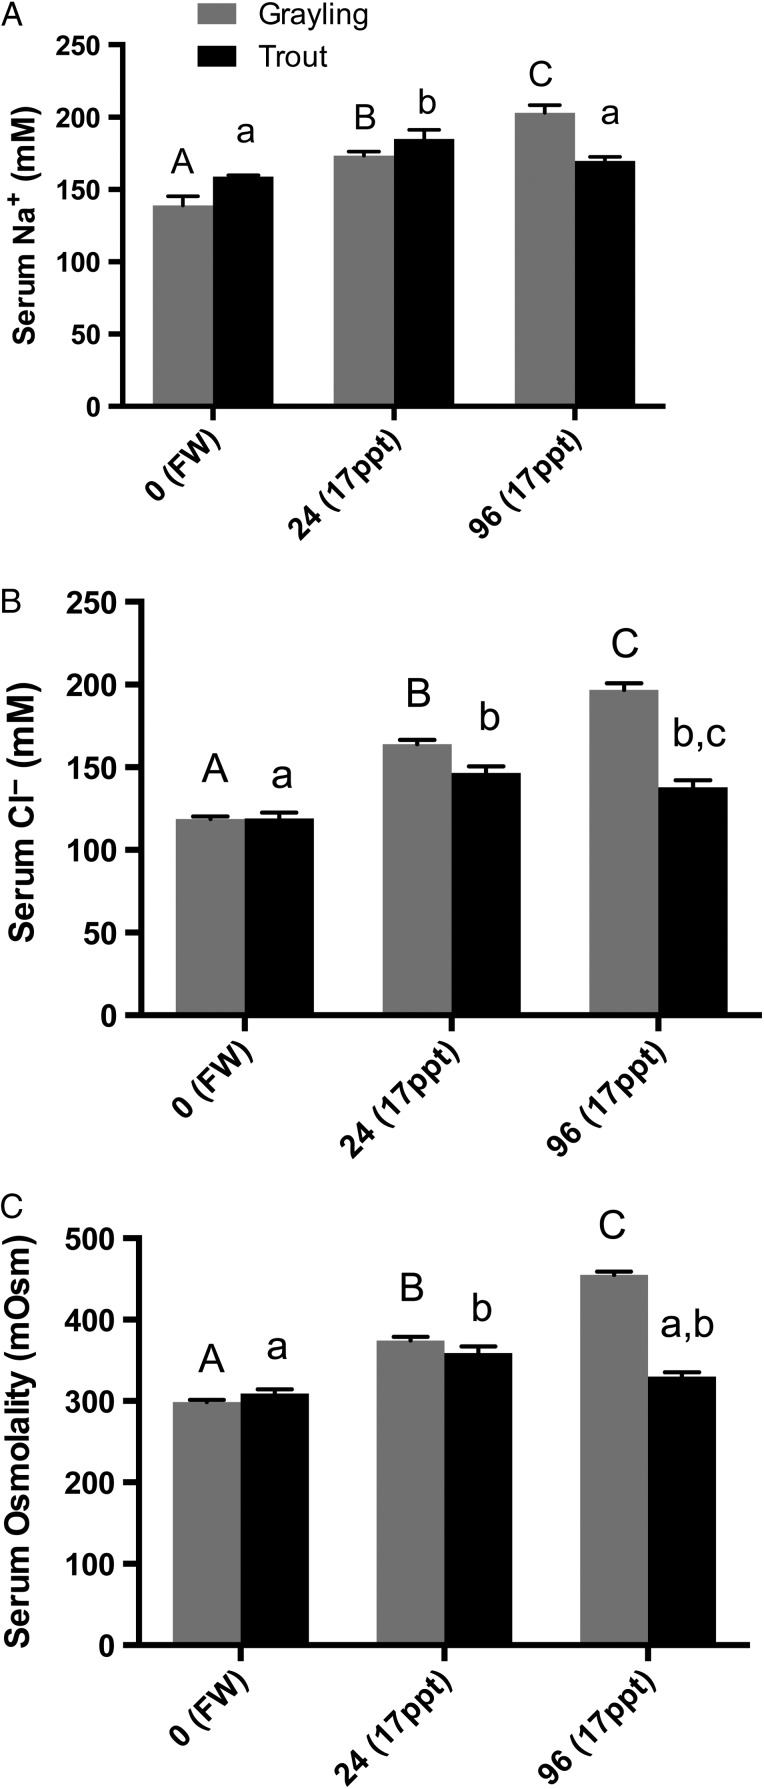
Serum sodium [Na+] (A), serum chloride [Cl−] (B) and serum osmolality (C) of Arctic grayling and rainbow trout exposed to freshwater (control; FW) and 17 ppt saline water at 24 and 96 h. Grayling and trout demonstrating significant increases in serum ions and osmolality at 24 h, and by 96 h serum concentrations were further elevated in grayling, but rainbow trout levels returned near to or were at control values. Grayling (grey bars) and rainbow trout (black bars) values are means + SEM, while dissimilar letters demonstrate significance using one-way ANOVA and Tukey's multiple comparisons. Capital letters denote grayling significance in comparison to grayling freshwater, whereas lowercase letters denote rainbow trout significance (n = 8, P < 0.05, one-way ANOVA).